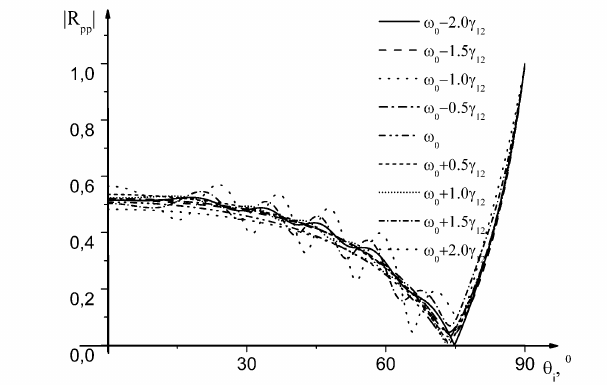
Fig. 4 . Angular dependence of the modulus of the amplitude reflection coefficient R sp in the vicinity of the resonant frequency